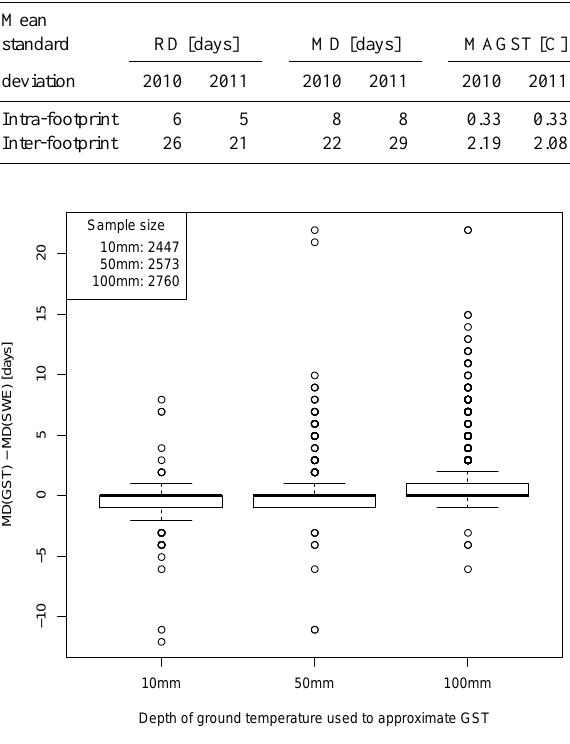
Fig. 4. MD based on SWE compared to MD based on GST from three different depths. Both SWE and GST were modelled with GEOtop. The length of the whiskers is 1.5 times the interquartile range.